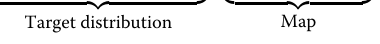
addition, GPS has no dependence on the map, as shown in Fig. 2. We propose the weight of importance equation using the Bayesian rule and Markov assumption is implemented for the two RBPFs of FS 1.0 in Eq. (7) and FS 2.0 based on GPS and LIDAR in Eq. (9). Given that observation z is